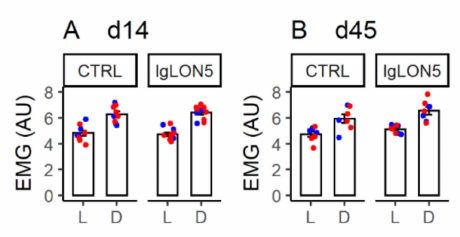
Figure 3. Average neck muscle electromyogram root mean square (EMG, in arbitrary units, AU) during the light (L) and dark (D) period in female wild-type (blue) and hTau (red) mice with intracerebroventricular infusion of antibodies from a patient with anti-IgLON5 disease (IgLON5) or from a control (CTRL) subject. Panels ( A , B ) show results obtained at the end of the 14-day infusion (d14) and ≥ 1 month afterward (d45). Bars show means ± SEM. Dots show values in individual mice. Detailed statistical results are reported in Table A1.